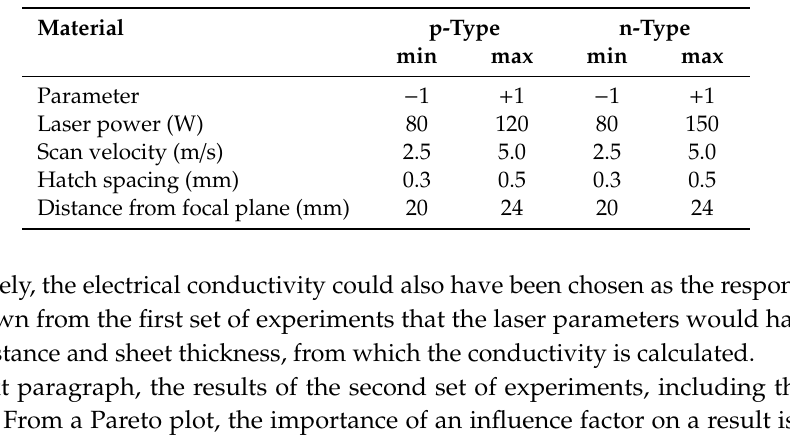
Figure 3. Differential scanning calorimetry (DSC) results for dry n-type paste (red dotted line shows temperature curve).